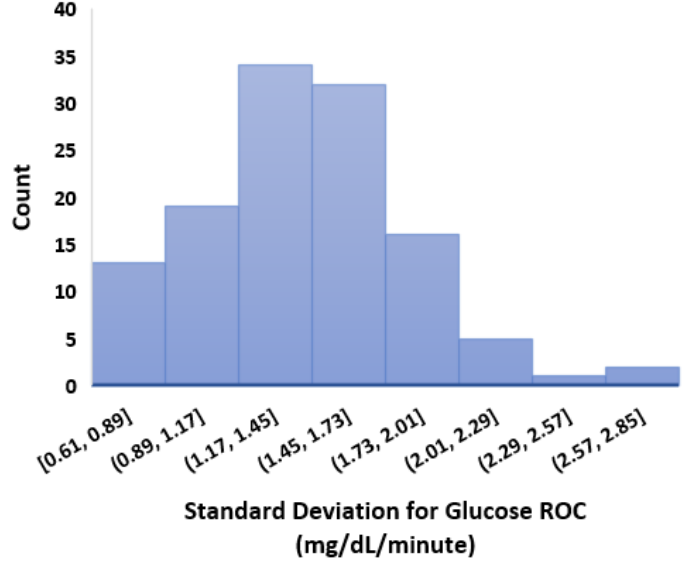
Figure 4. Standard deviation of glucose rate of change. Total number of individuals ( n ) =